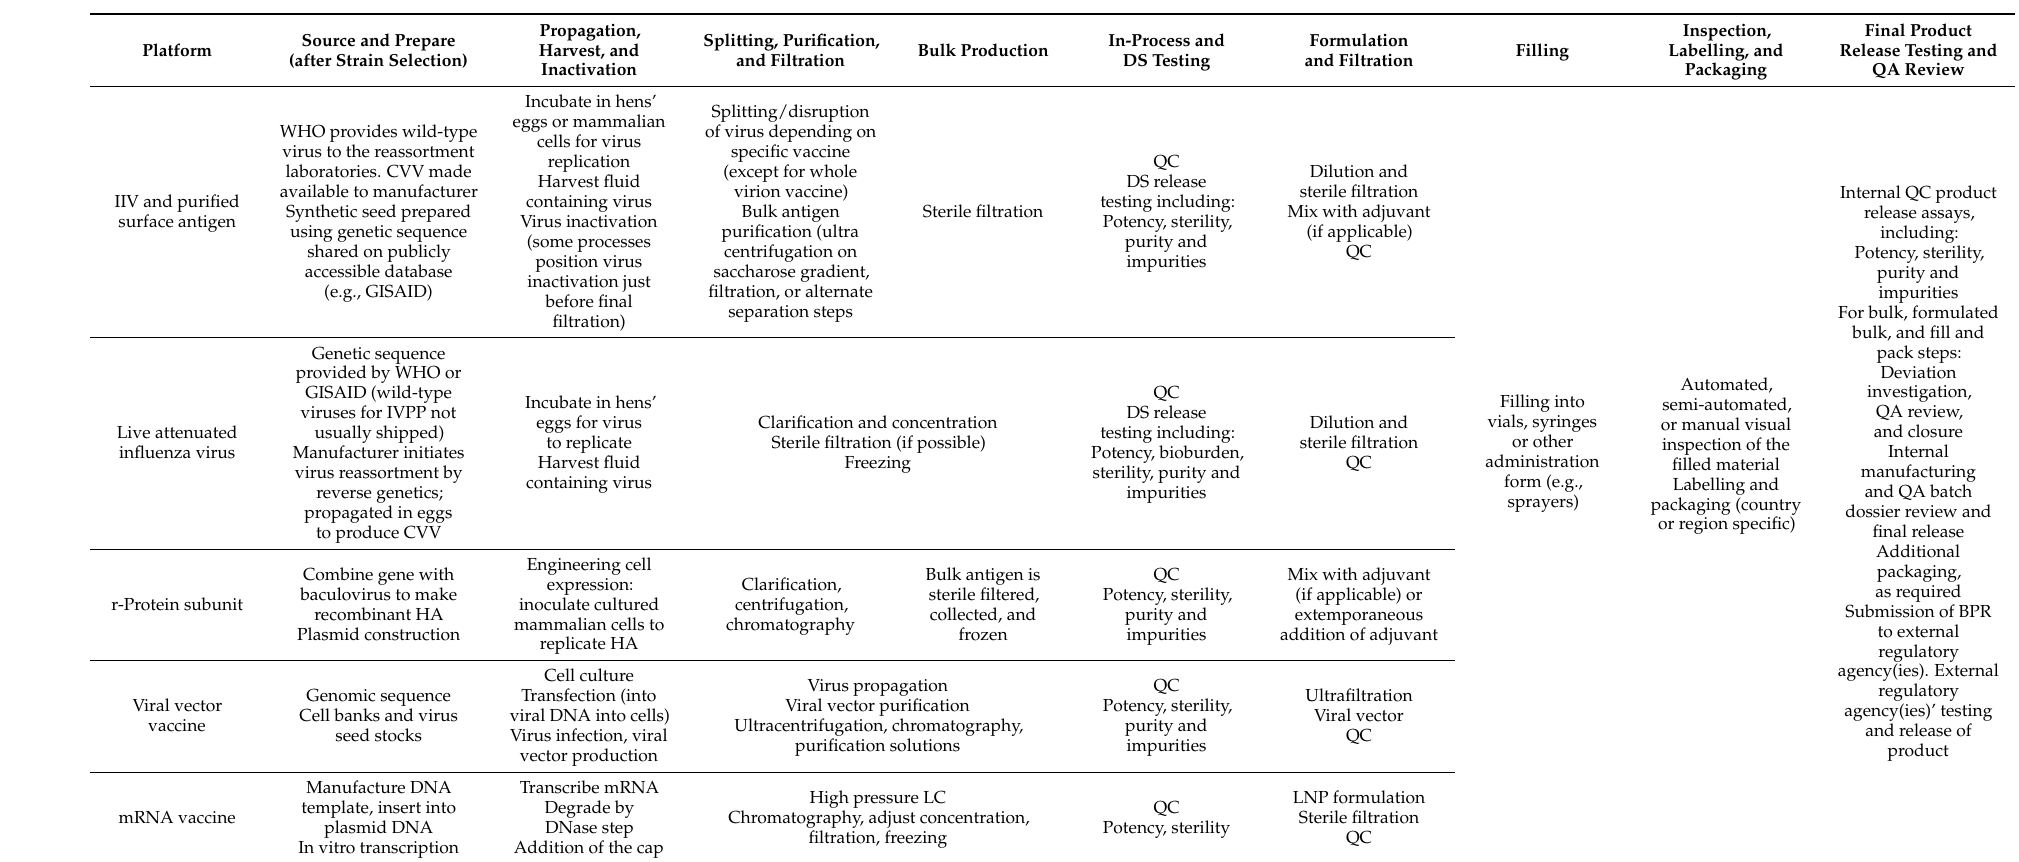
Table 2. Key manufacturing steps for selected vaccine platforms